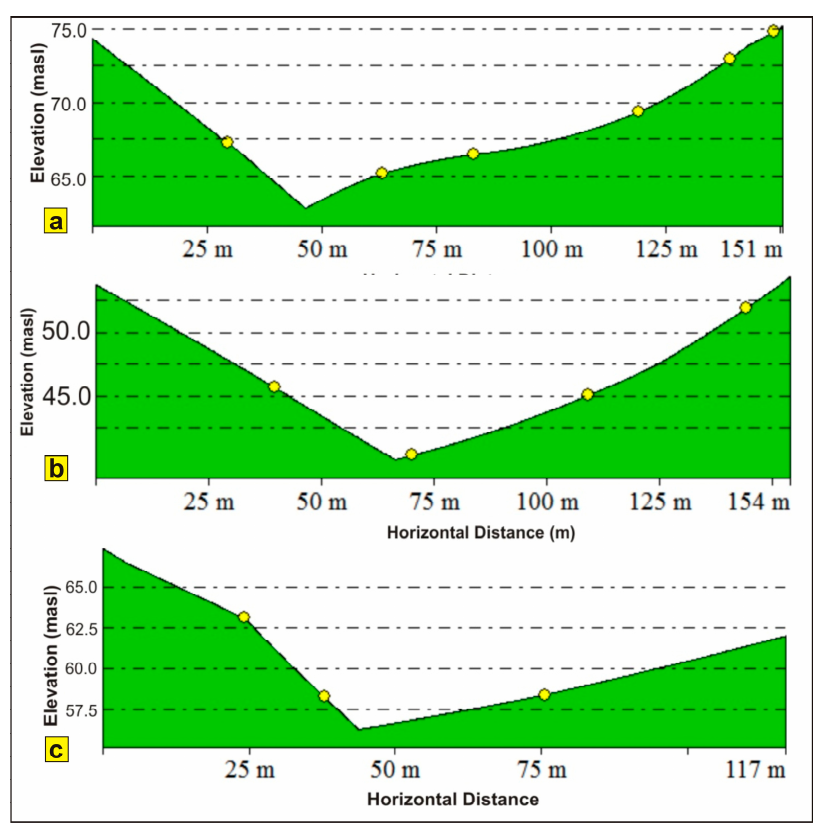
Figure 8. Cross section A-A’ along the site of the proposed dams: ( a ) Wadi Amlaha; ( b ) Wadi Maier; ( c ) Wadi Habran Sub-Watershed.